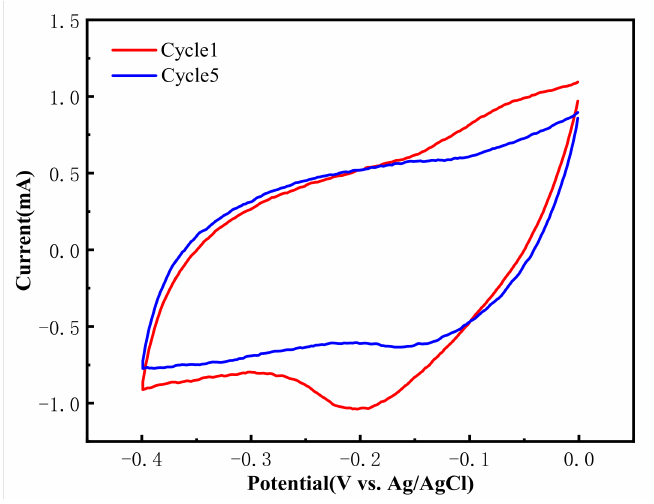
Figure 9. Cyclic voltammograms of PAQ/MWCNTs composite electrodes at reduction